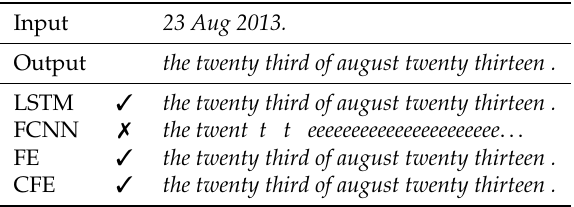
Table 9. Predictions obtained by the four different models for a selected sample case in the experiment E1. The output produced by FCNN is incorrect since it falls in an infinite